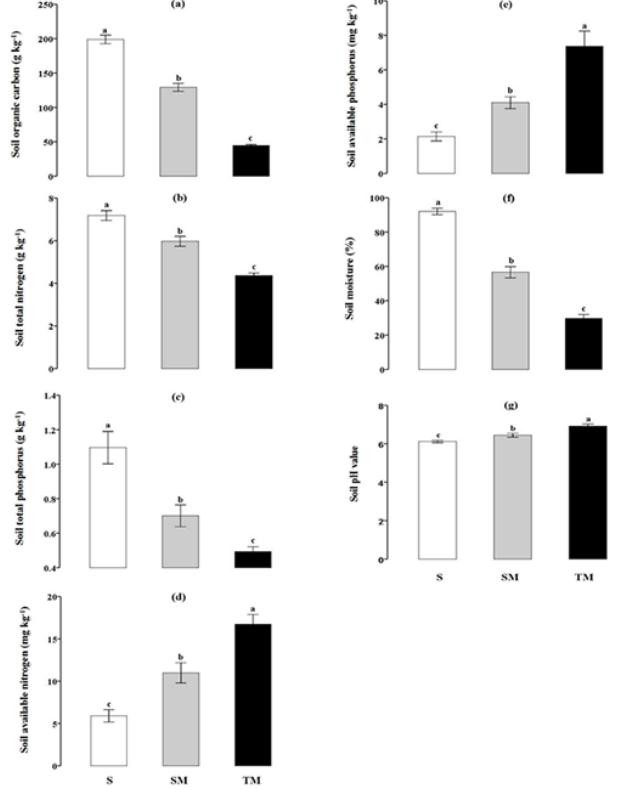
Figure 4. The changes in soil properties across three habitats. S is swamp, SM is swamp meadow, and TM is typical meadow. Signifi- cant differences indicated by dissimilar letters above each bar were determined using Tukey’s honest significant difference (HSD) test ( P <0.05) after one-way ANOVA.